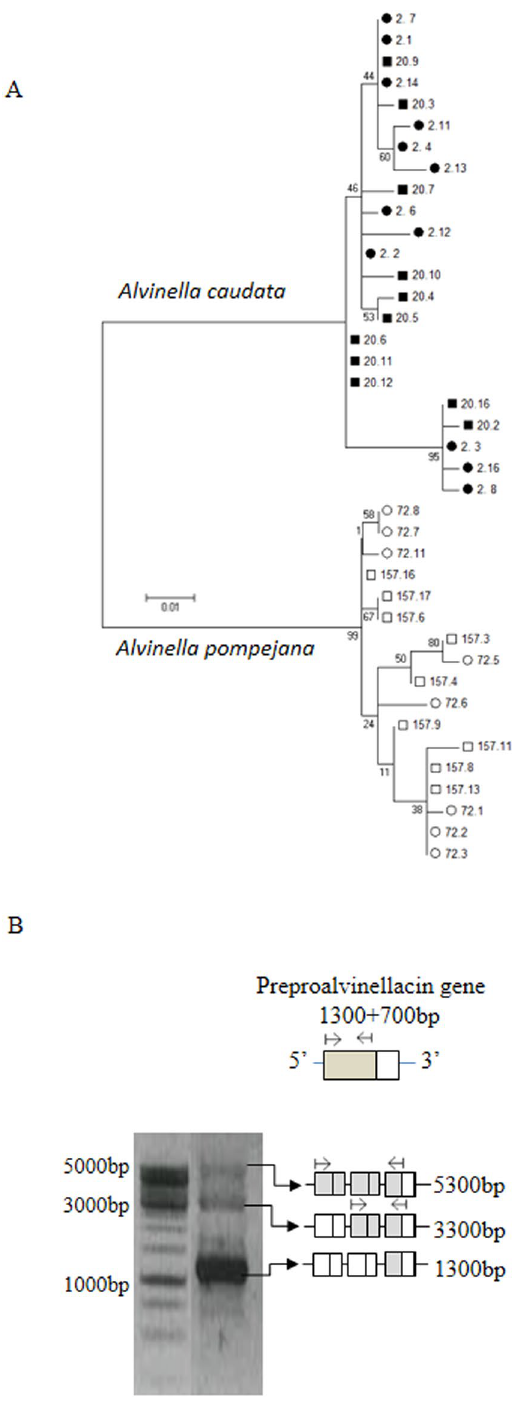
Figure 1. Gene diversification of preproalvinellacin. ( A ) Coalescence tree of alleles found in two well- recaptured individuals of Alvinella pompejan a (white) and its sister species Alvinella caudata (black), and ( B ) molecular evidence that it comes from tandemly repeated gene duplications in A. caudata . ( A ) Reconstruction of lineages without recombination was performed on the 3 ′ region on all nucleotide sites by Maximum Likelihood using the K2P model in MEGA 5.0. Allele coverage: A. caudata : two individuals with 15 clone recaptures each, A. pompejana : two individuals with 50 clone recaptures each. ( B ) Agarose gel electrophoresis with a 1 kb DNA ladder showing the amplification of the 1300 bp 5 ′ region of the A. caudata preproalvinellacin (complete gene: 2000 bp) using the 5 ′ primers (arrows). Longer extra bands indicate the co-amplification of two and three linked genes as summarized by the boxes representing the tandemly-duplicated gene and the position of the PCR